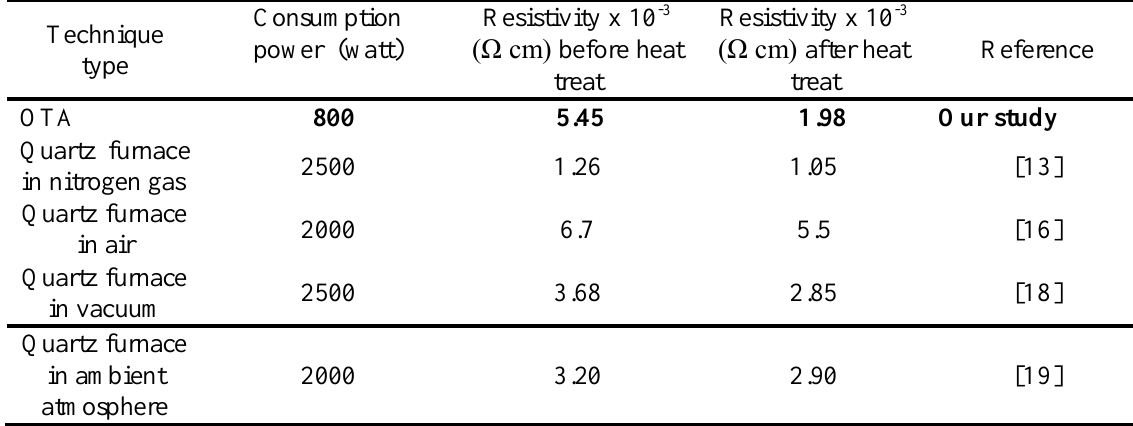
Table 3. Show the resistivity of the ZnO thin film before and after treated by OTA processes at 300 ⁰ C compared with those of other researchers.